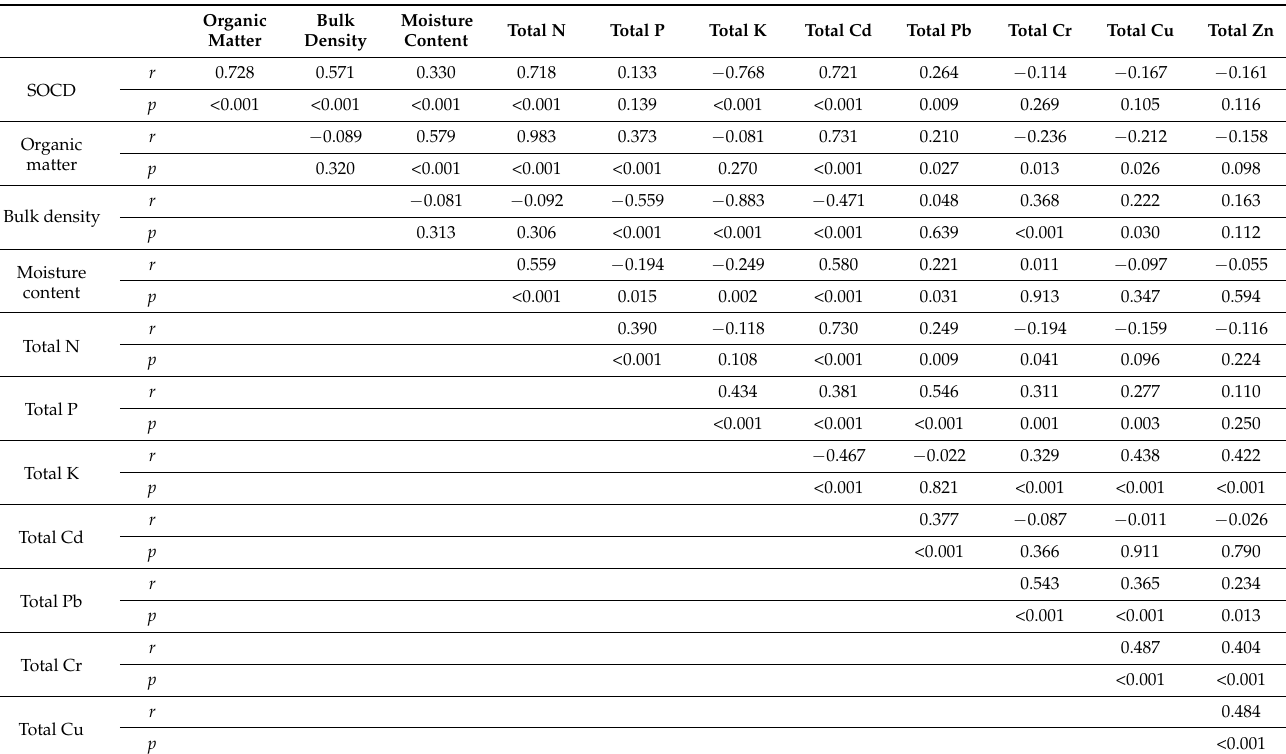
Figure 5. Relationship between soil organic carbon density and soil nitrogen content in West Mauri Lake. Table 1. Correlation of soil organic carbon with physiochemical factors in the lakeside of West Mauri